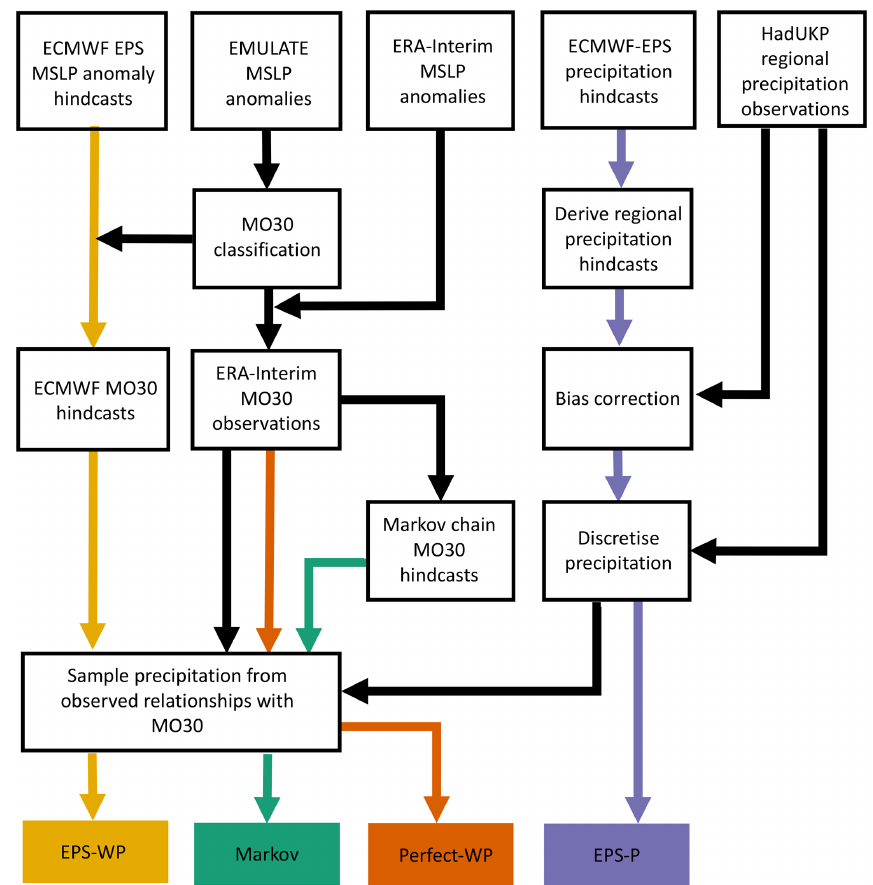
Figure 2. Schematic showing the procedure for the four precipitation forecast models. The top row shows the base data sets used, and the bottom row shows the four models. Coloured arrows begin at the first stage for which forecasts are issued: EPS-WP forecasts begin with the ECMWF prediction system MSLP forecasts, Markov forecasts are produced once the ERA-Interim MO30 time series has been derived, and Perfect-WP “forecasts” are observations from the same time series, while EPS-P forecasts are the post-processed data from the ECMWF forecast